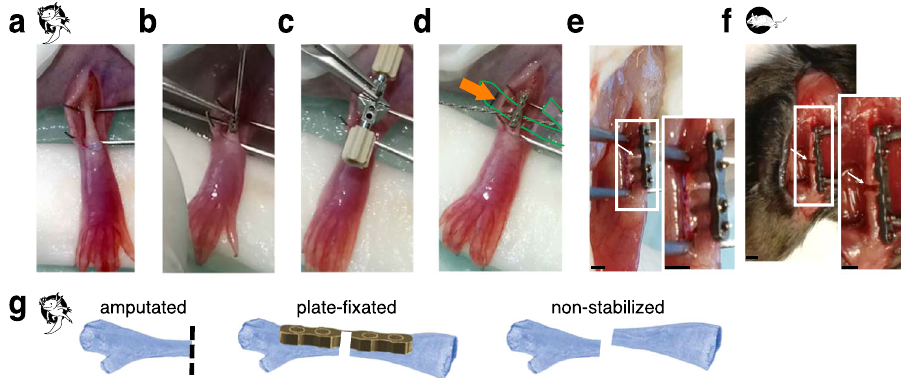
Fig. 2 Overview of the surgical procedure and the experimental setup. a ≥ 20 cm snout-to-tailtip axolotl femurs were exposed by dissecting upper hind limb skin and spreading the muscles above the femur. b A titanium plate (7.75 mm Plate, RISystem, Switzerland) was attached to the femur by 4 titanium screws. c A saw guide was used for osteotomy. d A Gigly wire (0.66 mm) was inserted under the bone and used for sawing. Green outline and arrow show the plastic foil used for soft tissue protection during the surgery. e Osteotomy resulted in 0.7 mm bone gap in axolotl (white arrow). f 0.7 mm fracture of mouse femur is shown (white arrow). Here, a 6-hole plate (10 mm MouseFix Plate XL, RISystem) was attached to the femur by 4 titanium screws to fi xate the bone. Scale bars 1 mm. g Sketch of the three different osteotomy models used. Amputation of the limb at the mid-femur (left) leads to blastema formation in the region of the proximal femur end of the osteotomy gap of the plate- fi xated fracture (middle) and the non-stabilized fracture (right). In the non-stabilized fracture the two bone ends do not stay aligned but converge in a random way. Dashed line shows the amputation